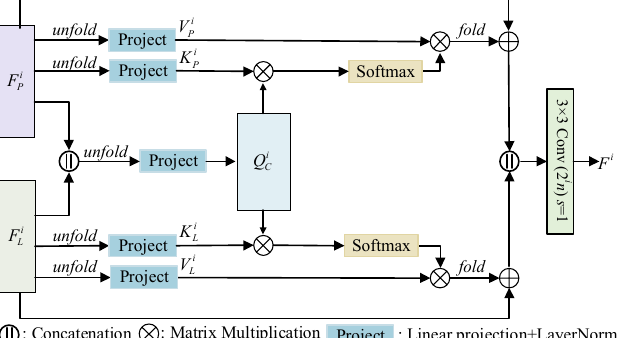
Figure 3. The architecture of SIAM.